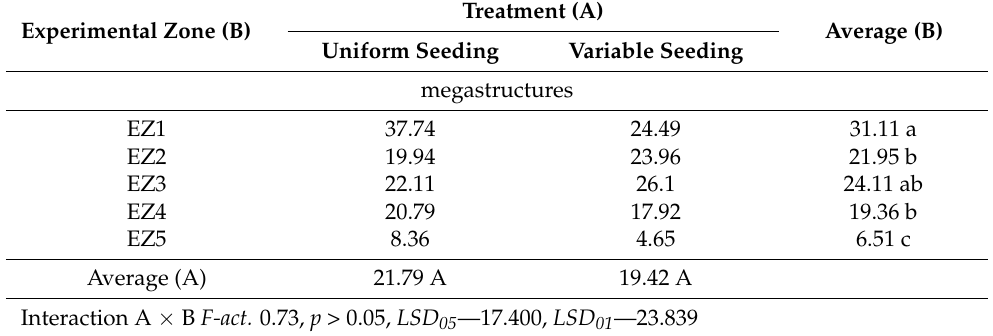
Table 2. Soil structural compositions for different zones and seeding treatments of experiment